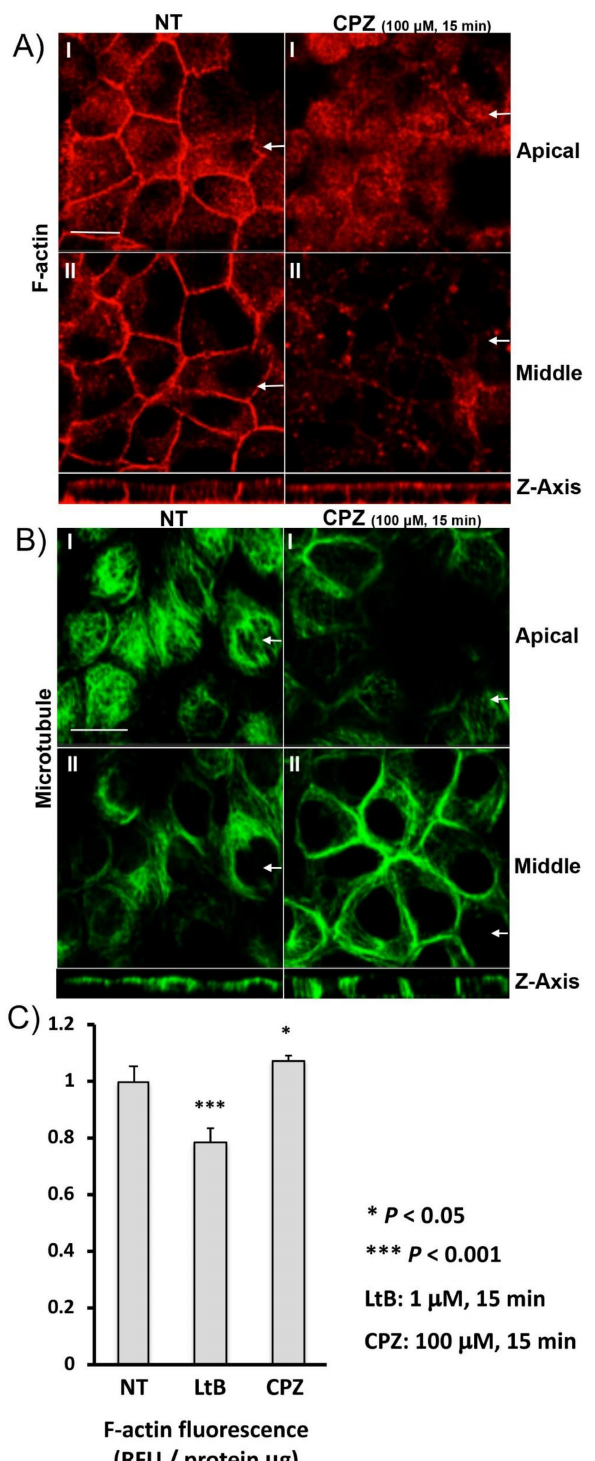
Figure 5. CPZ selectively disrupts basolateral actin but increases basolateral tubulin in polarized MDCK cells: ( A ) AQP2-MDCK cells were treated 15 min with 100 µ M CPZ (right panels) or without CPZ (NT, left panels). F-actin was visualized using rhodamine phalloidin. The larger panels represent confocal sections of the apical (‘) and the middle region (“) of the cell monolayer. The smaller